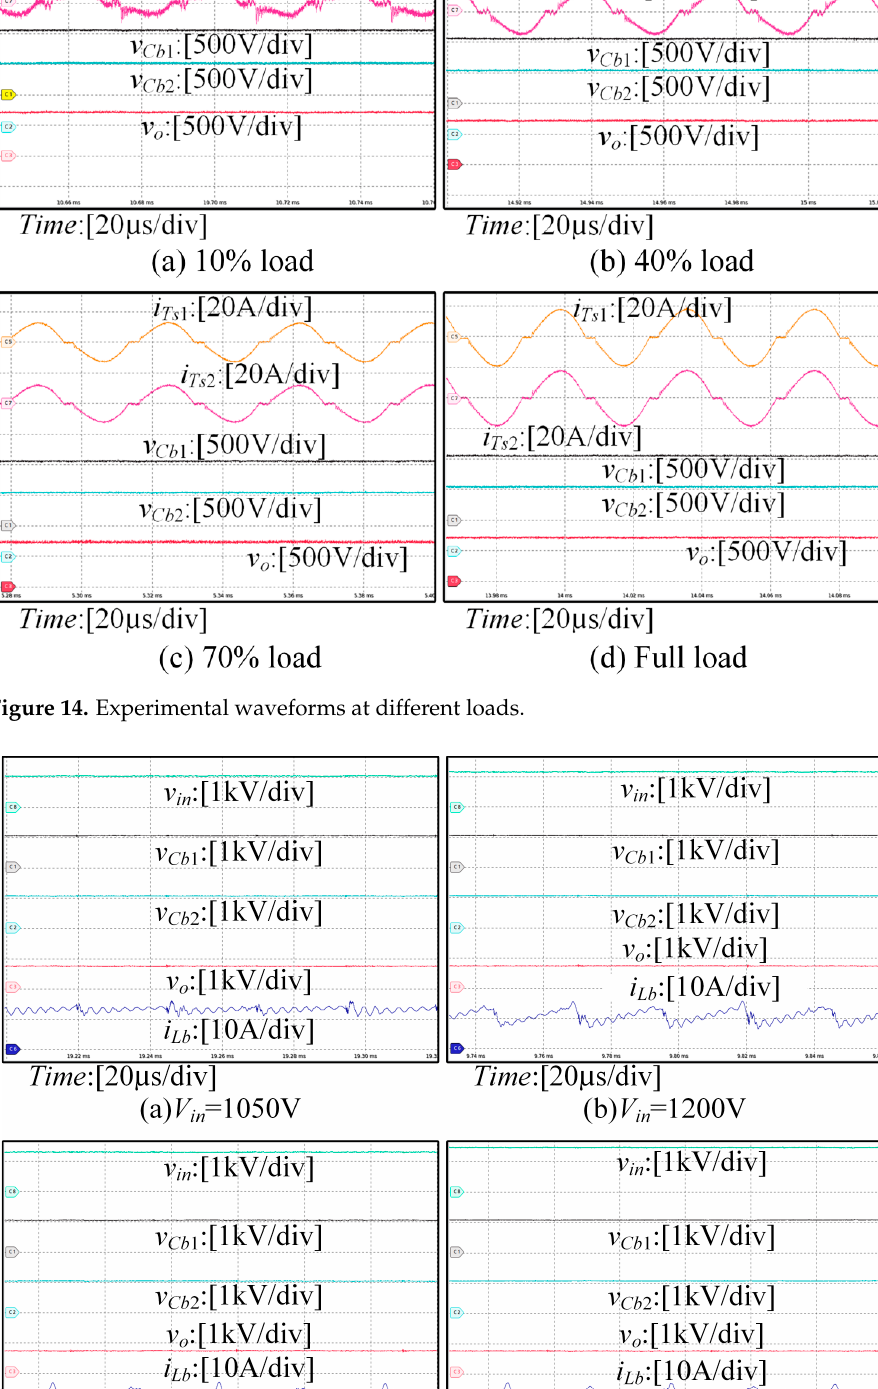
Figure 16. Experimental waveforms when the load and input voltage change. ( a ) Experimental waveform of load jump; ( b ) experimental waveform of input voltage variation.